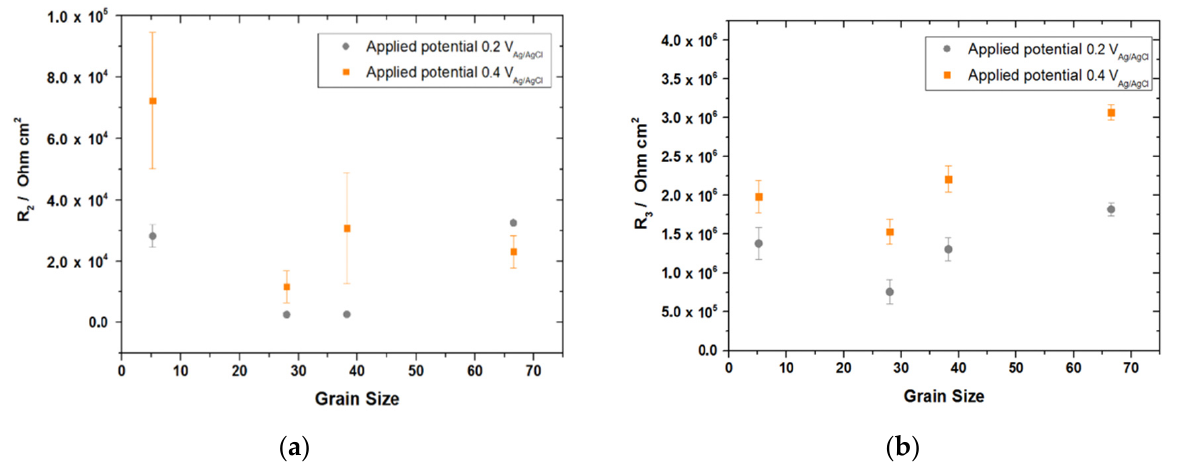
Figure 9. Resistance values of ( a ) R 2 corresponding to the double layer and ( b ) R 3 corresponding to passive layer.